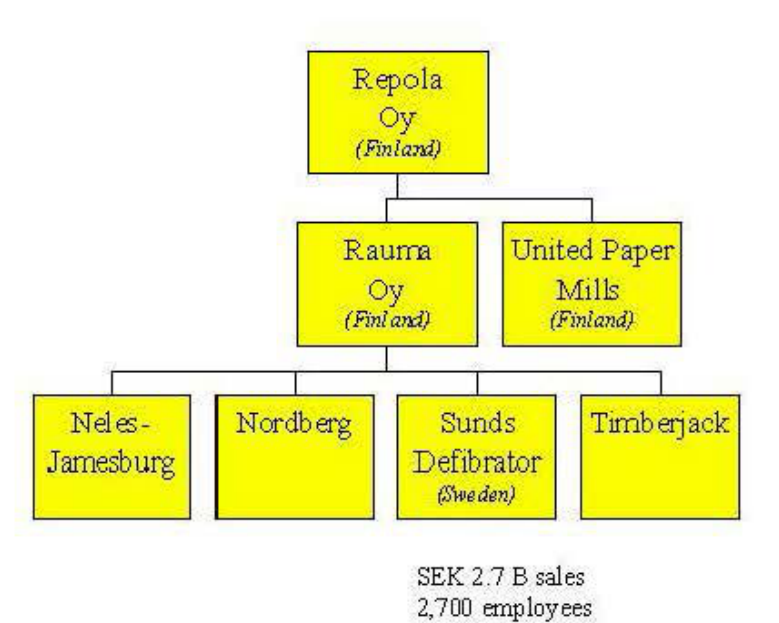
Figure 8. Sunds Defwrat,or - Raum.a Repola c. 1993